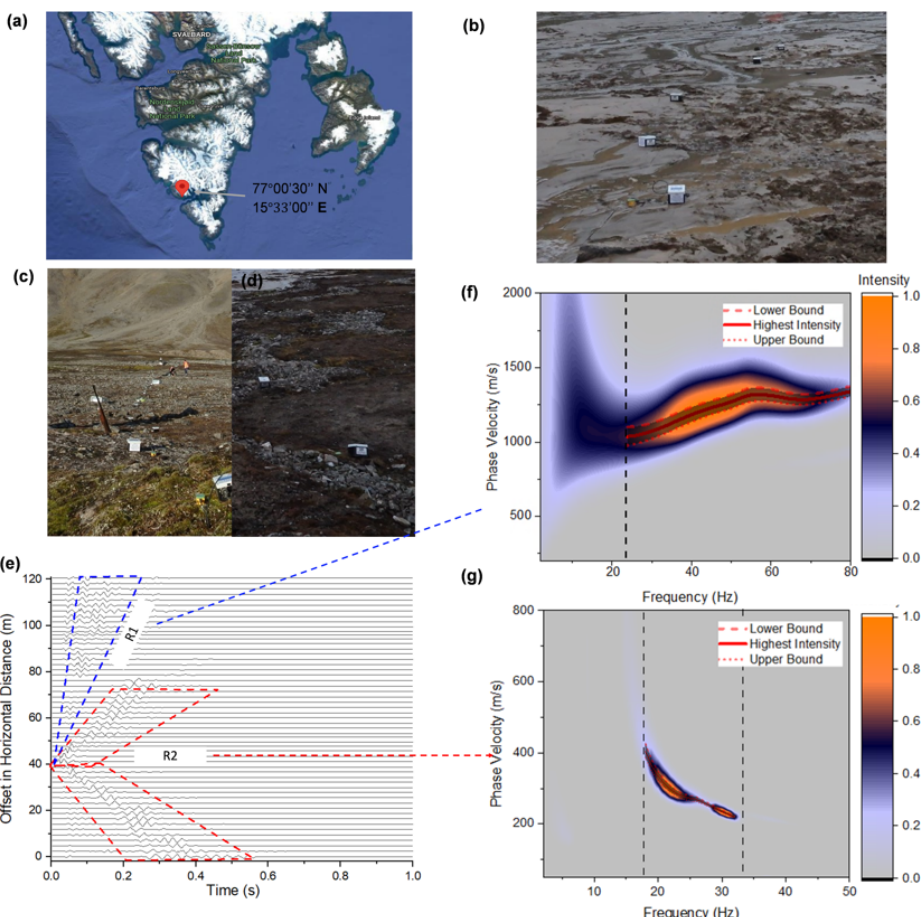
Figure 3. Surface wave measurement in section 1 (from 0 to 120m). (a) Study area in Holocene, Fuglebekken, SW Spitsbergen (imagery source: ©Google Earth, 77 ◦ 00 (cid:48) 30 (cid:48)(cid:48) N and 15 ◦ 33 (cid:48) 00 (cid:48)(cid:48) E). (b) Testing site with clayey silt soils. (c) Testing site with gravels and sands. (d) Testing site with patterned ground. (e) Waveform data from the measurements at different offsets in horizontal distance. (f) Experimental dispersion image for the R1 wave. (g) Experimental dispersion image for the R2